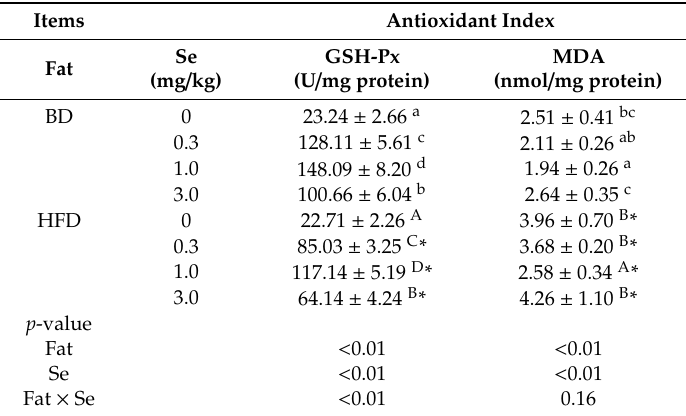
Table 5. Results of the levels of antioxidative parameters.